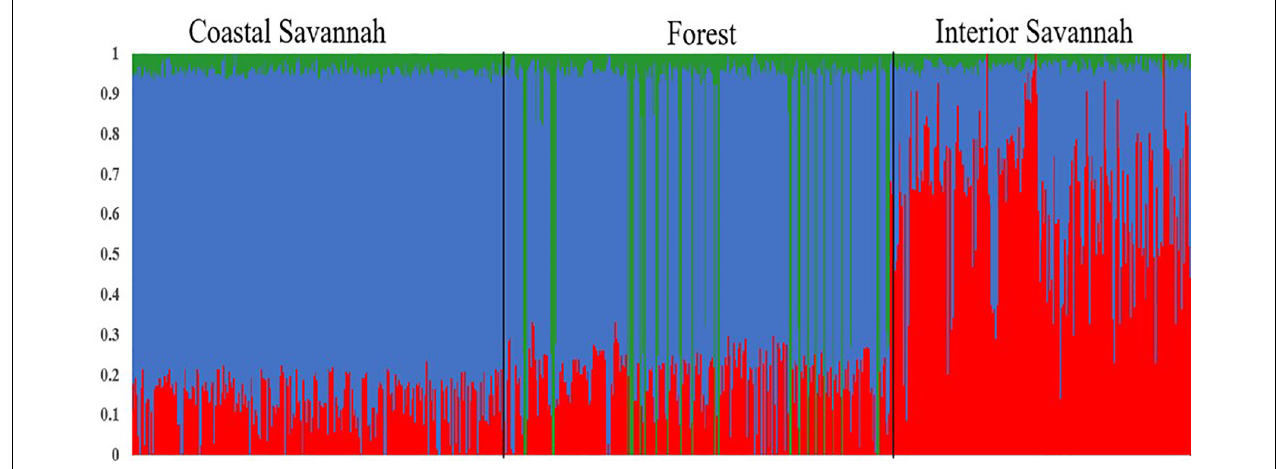
FIGURE 2 | Admixture plot showing mixed ancestry among birds from the three Ghana ecotypes: Coastal Savannah, Forest, and Interior Savannah.